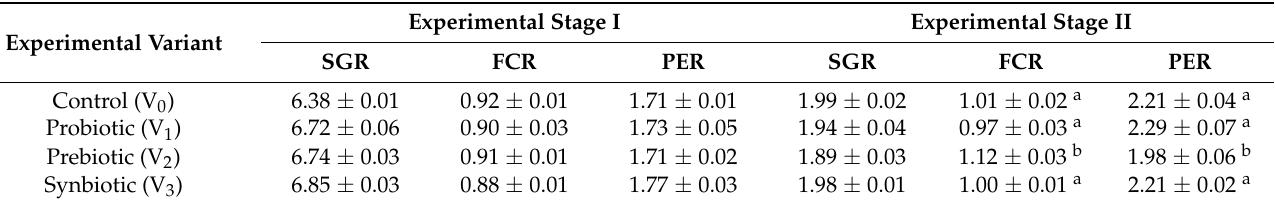
Table 1. The main indicators of tilapia growth performance in the two experimental stages. Experimental Stage I Experimental Stage Experimental Variant